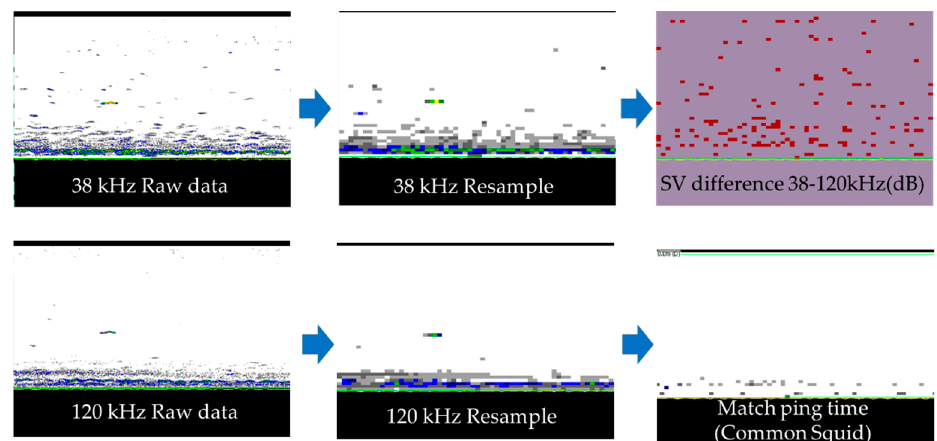
Figure 5. Common squid identification example.